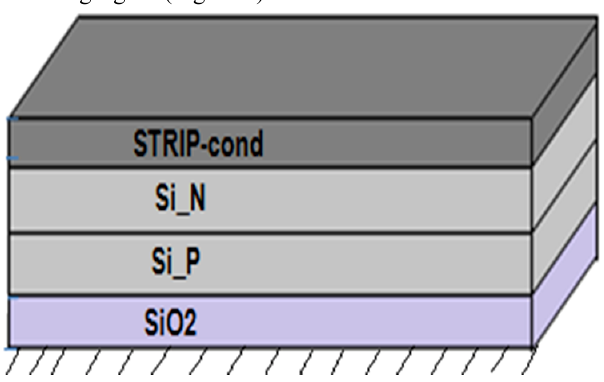
Figure 4. Structure of a simple Patch Antenna The patch antenna structure proposed is given by the following figure (Figure.5)